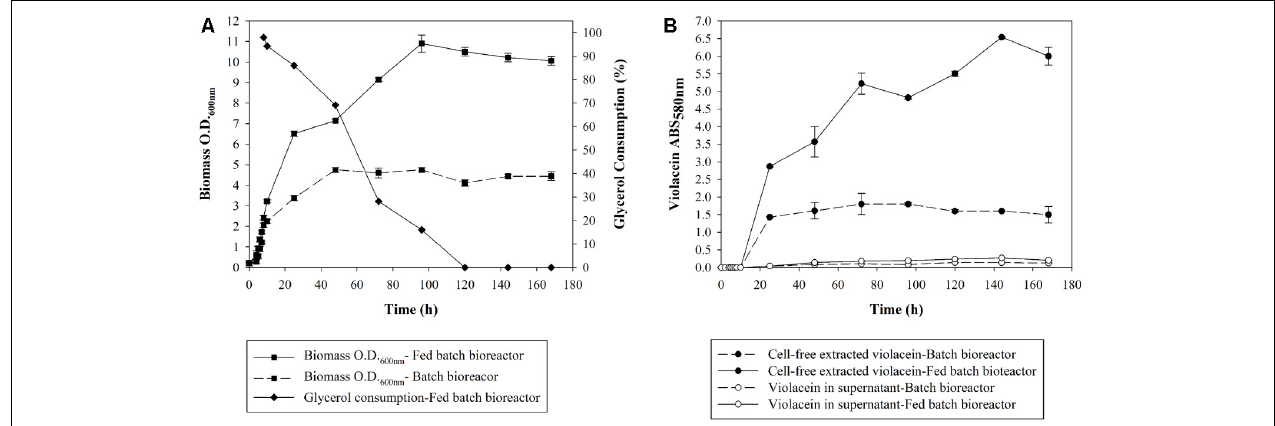
FIGURE 2 | (A) Optical density and glycerol consumption of J. lividum biomass and (B) crude violacein cell-free extracted or leaked in the supernatant produced in bioreactor at 25 ◦ C, pH 7, under monitored conditions of ventilation and diluted